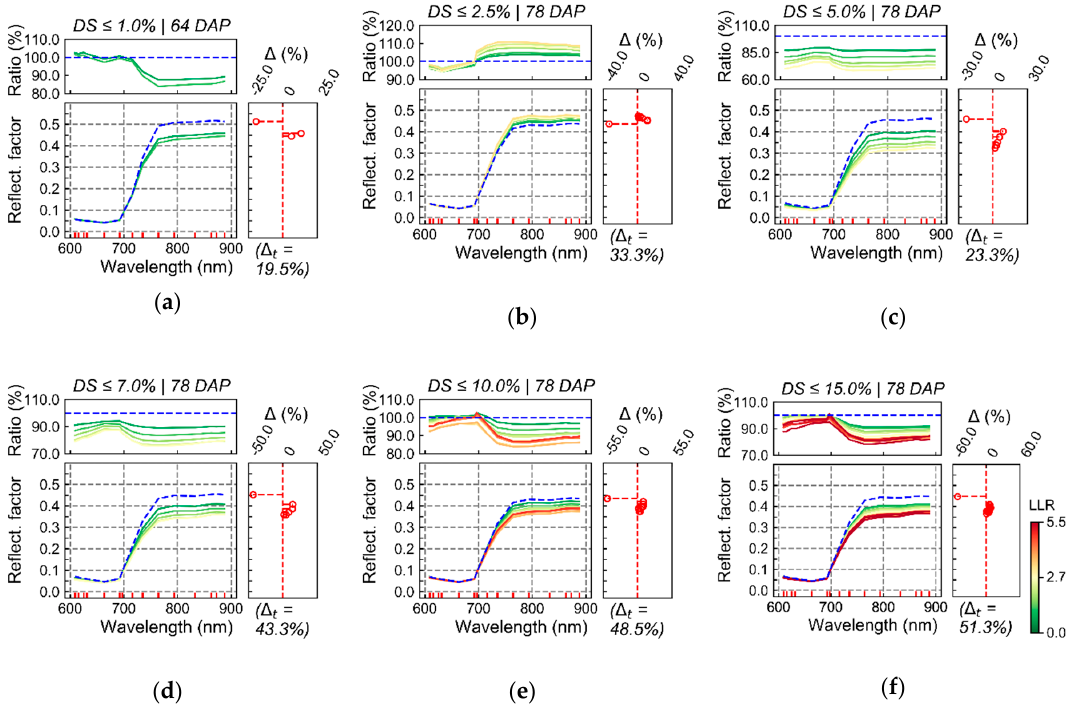
Figure 6. Average reflectance for pixels within discrete intervals of log-likelihood ratio (LLR) between 0 and 5.5, in steps of 0.5. LLR, in this case, compares pixel-wise probability estimated for diseased sampling units (SUs; H1; ≤ 1.0%, ≤ 2.5%, ≤ 5.0%, ≤ 7.0%, ≤ 10.0% and ≤ 15.0% disease severity, in a – f , respectively) in contrast to healthier SUs (H0; only healthy plants for 64 DAP or disease severity below 1.0% for 78 DAP). Colors of the spectral curves indicate the average LLR value for pixels included in a given interval. Ratio indicates the division of reflectance corresponding to a given LLR interval by that from the interval with the lowest LLR values (i.e., for pixels with LLR below 0.5; indicated by the blue line). Delta ( ∆ ) corresponds to the percentage of observations (pixels) within a given LLR interval for SUs from a specific disease severity class subtracted from the percentage of observations in the same LLR interval for the healthier SUs used as reference. Delta is plotted in front of each average spectral signature for the corresponding LLR interval. Delta total ( ∆ t) indicates absolute cumulated delta values.